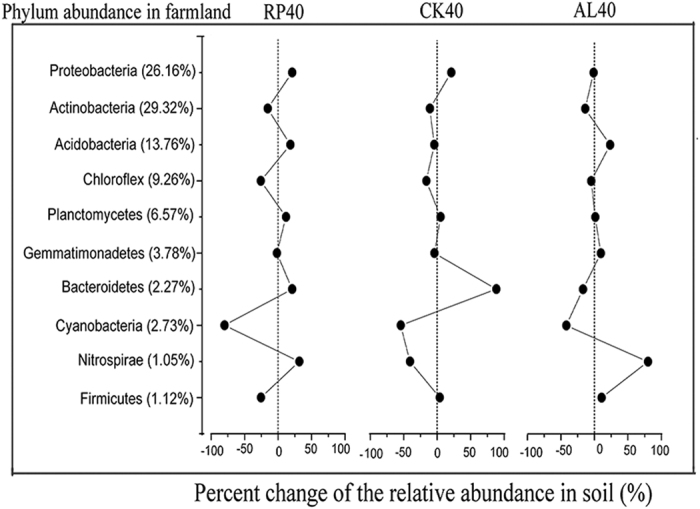
Distribution of 16S rRNA sequences across bacterial phyla communities following afforestation.